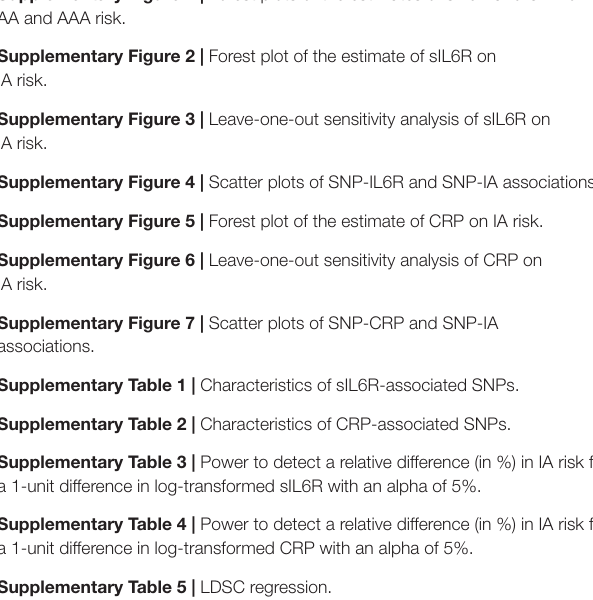
Supplementary Table 5 | LDSC